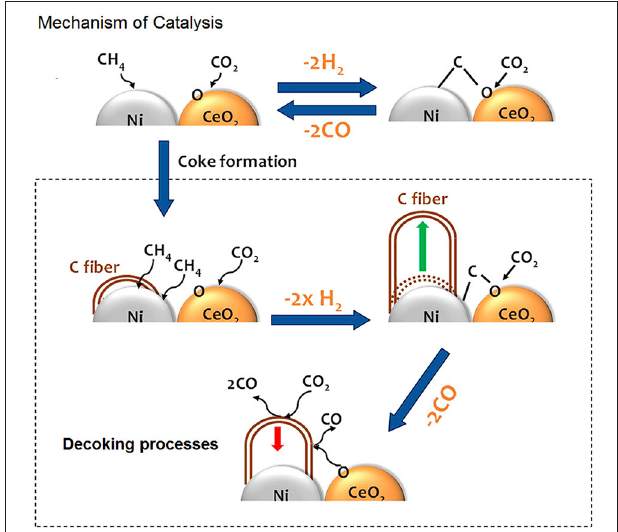
FIGURE 5 | In presence of ceria the kinetics follows a Mars-van Krevelen mechanism, where active carbon is oxidized by CeO 2 , while oxygen vacancies are replenished by O from CO 2 dissociation; the carbon fibers growth is hindered by CeO 2 , which provides extra oxygen for their gasification. Adapted from Liang et al. (2018) with permission of ACS